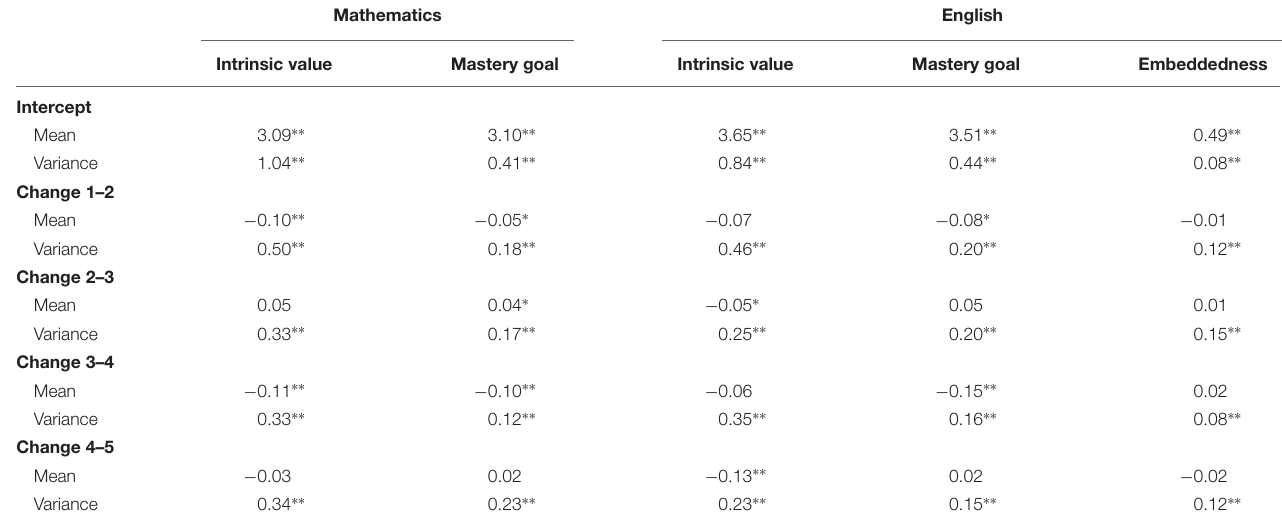
TABLE 4 | Summary statistics (latent